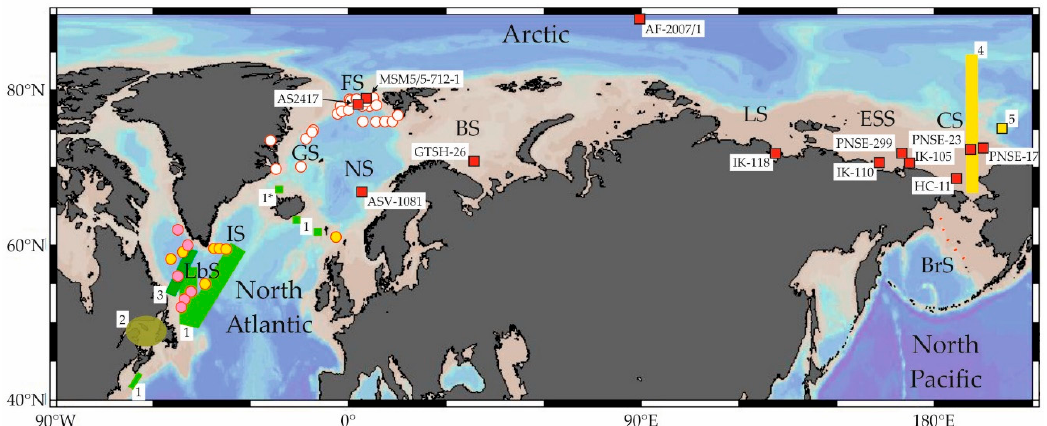
Figure 3. Observations of N. seminae in the plankton, sediment trap, surface, and Holocene sediment samples in the Arctic Ocean and North Atlantic. Plankton samples: 1 as green bars and squares, 1* as green square, 2 as a greenish oval, 3 as a dark-green bar, and 4 as yellow bar [7,8,14,15]. Sediment trap NAP samples: 5 as black-framed yellow square [16]. Surface sediment samples: red-framed white-, yellow-, and rose dots [9,12] and this study (Table A1).Holocene sediment cores: black-framed red dots with names on the white background [17–23,32]. LbS is Labrador Sea, IS is Irminger Sea, GS is Greenland Sea, NS is Norwegian Sea, FS is Fram Strait, BS is Barents Sea, LS is Laptev Sea, ESS is East-Siberian Sea, CS is Chukchi Sea, BrS is Bering Sea. Red arrows in Bering Sea show the northeastern limit of N. seminae permanent occurrence in surface sediments of the North Pacific (data mostly from the 1970s) [33]. The source of the blank map is Ocean Data View software [13].